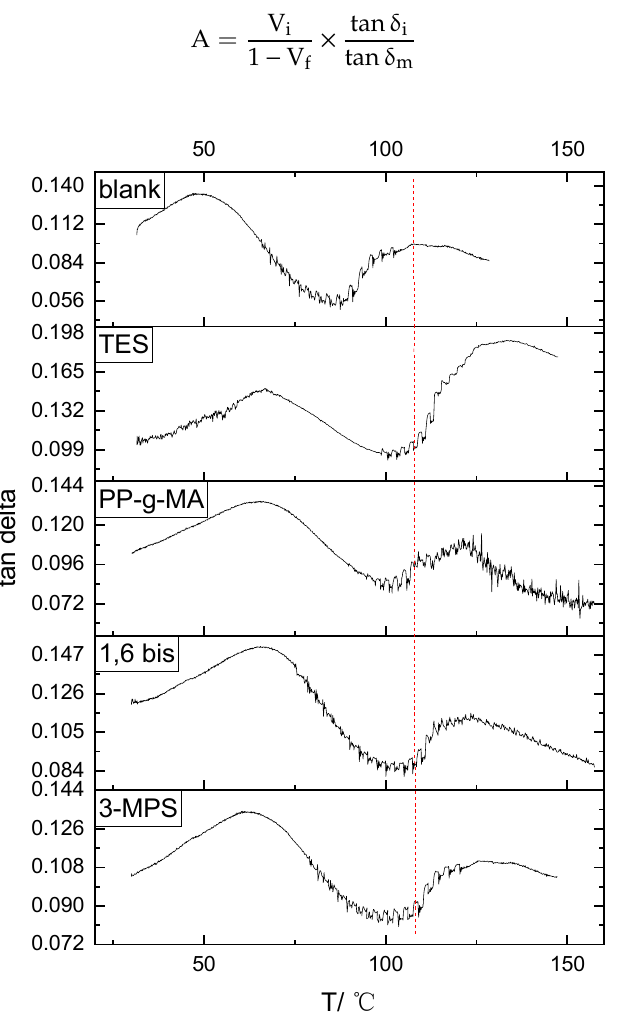
Figure 7. Tan delta–temperature relationship of coupling agents with different coupling agents treated with GF.